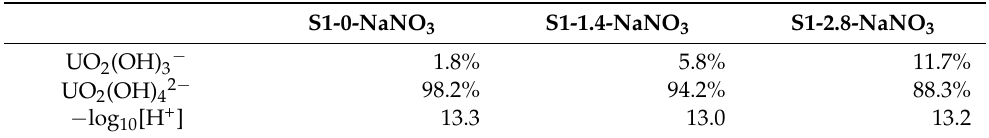
Table 3. U(VI) speciation and − log 10 [H + ] values calculated in the three solutions using the Ther- mochimie database [32] (https://www.thermochimie-tdb.com/pages/extraction.php, accessed on 8 September 2022) and SIT for activity coefficient correction [3,37].